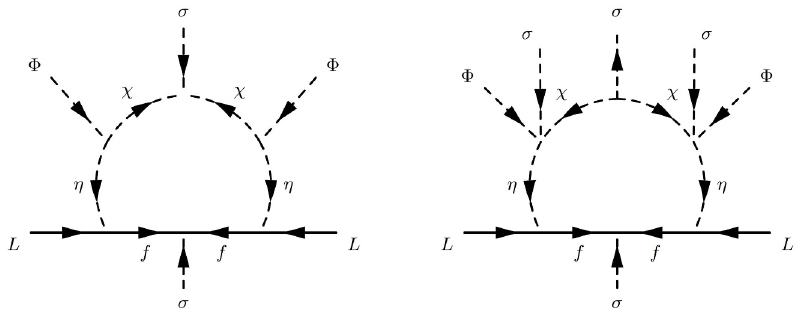
Figure 3 . One-loop diagrams that contribute radiatively to neutrino